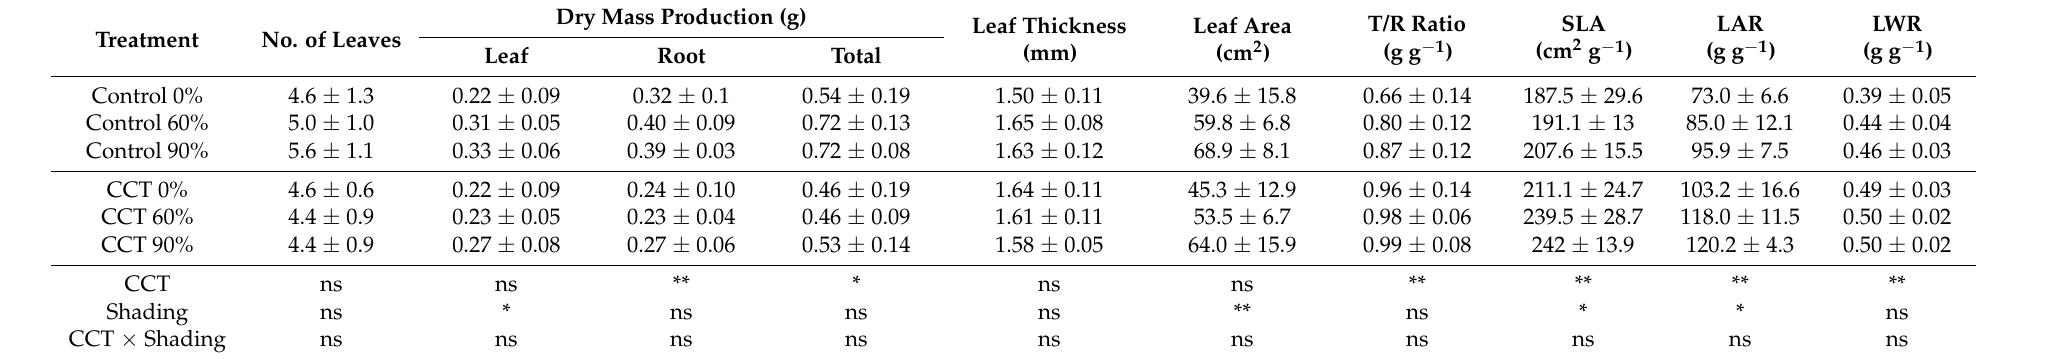
Table 2. Effects of shading level on growth characteristics of Sedirea japonica under control (CO 2 = 400 ppm) and CCT (climate change treatment, CO 2 = 650 ppm, temperature = control + 3 ◦ C)